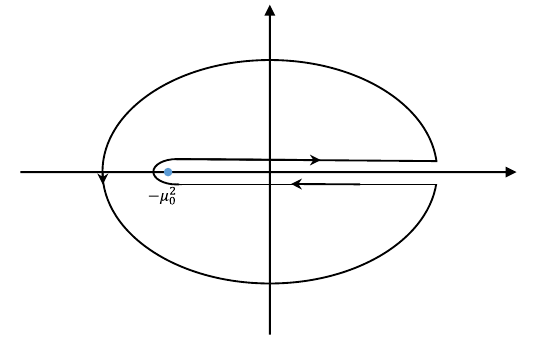
Fig. 1 Cauchy theorem: The horizontal axis represents the real part of μ 2 , and the vertical axis represents the imaginary part of μ 2 E